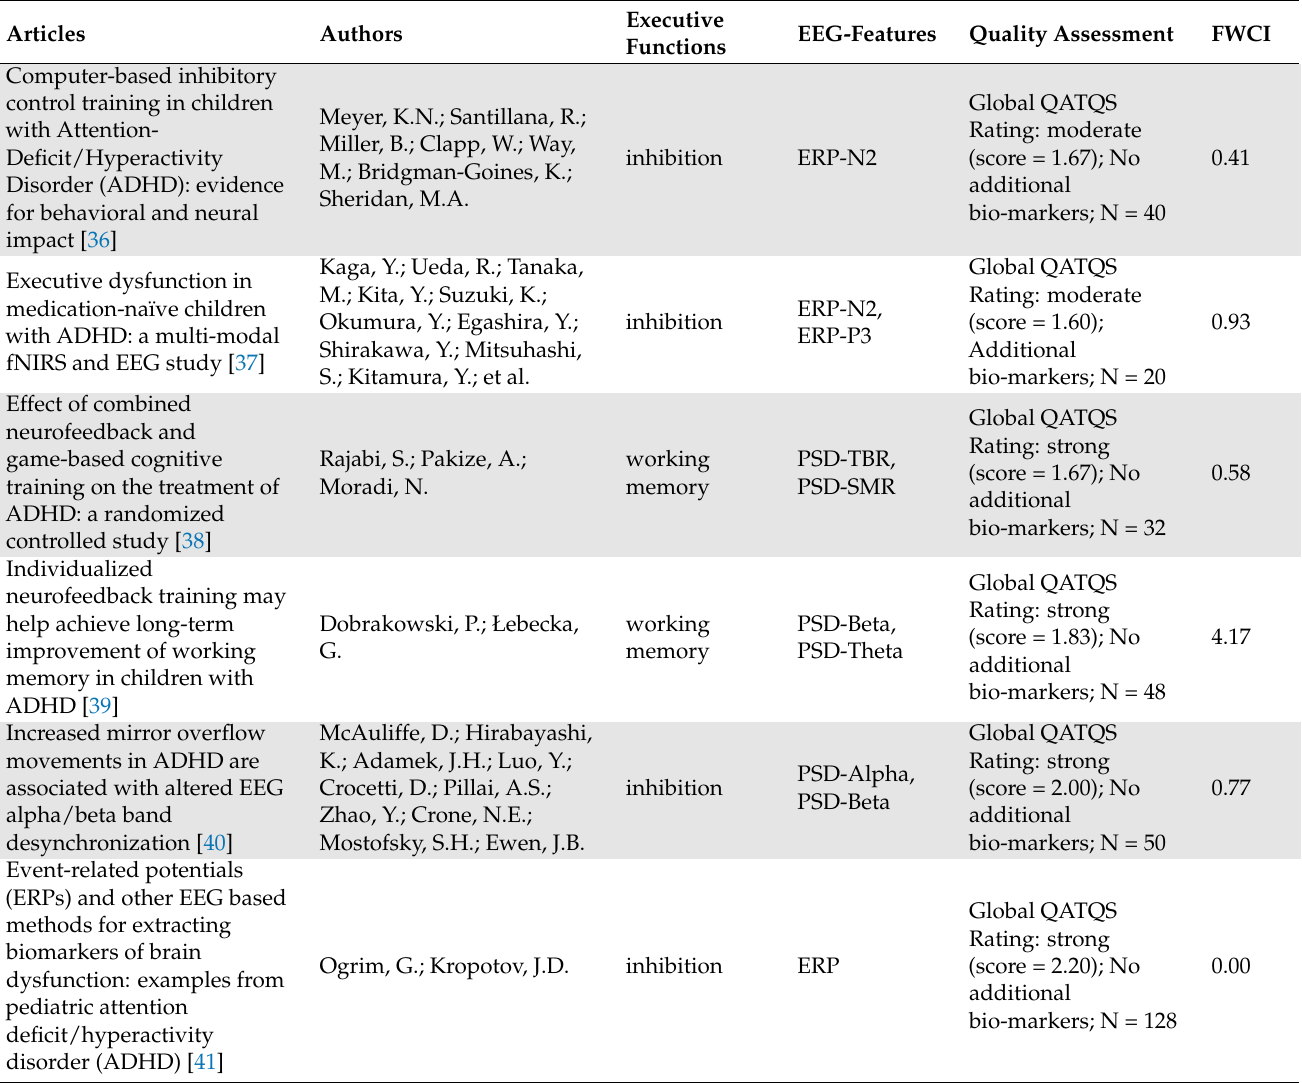
Table 2. List of articles and related executive functions. EEG features and quality scores.